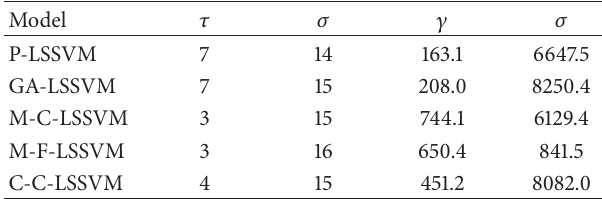
Table 1: The optimal parameters combination of five models for FM broadcasting band.